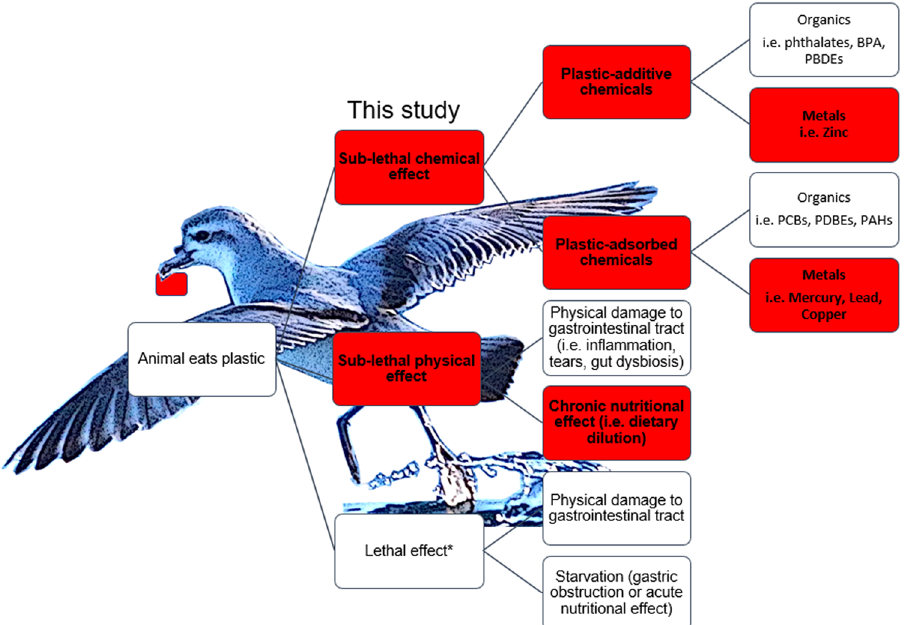
Figure 1. Ingestion of plastic by seabirds and other animals may lead to both lethal and sub-lethal health effects, including physical effects, linked to physical damage and nutrition, and chemical effects,